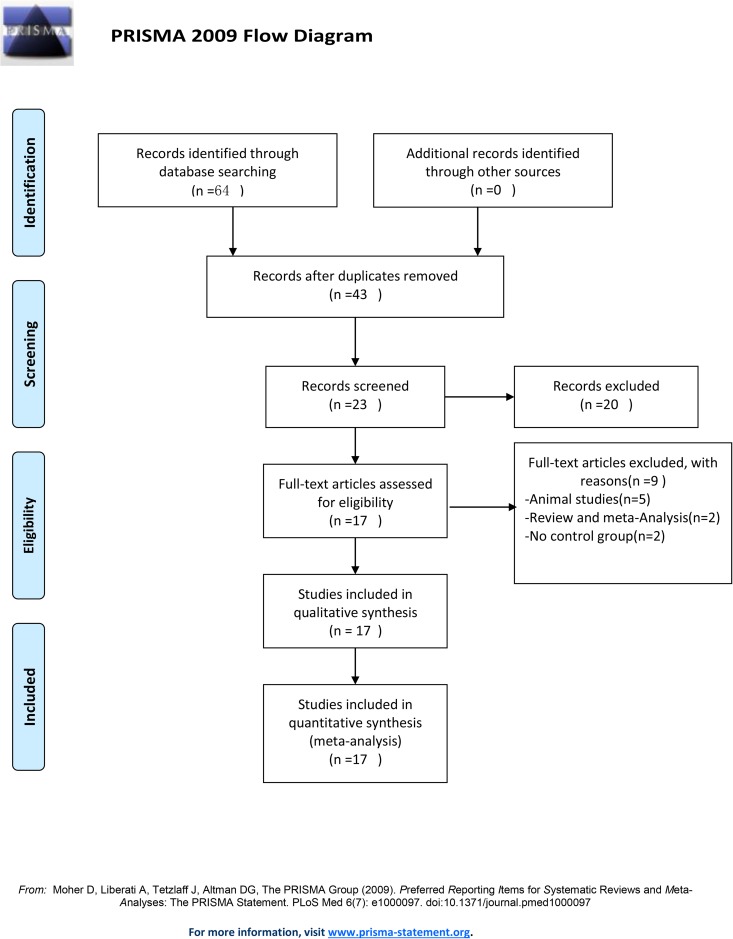
Flowchart of selection of studies for inclusion in meta-analysis.A total of 64 studies were identified, and 21 studies were excluded because of duplication. After reading the titles and abstracts, 20 studies were excluded. 23 possible full text studies were carefully reviewed (animal studies [n = 5]; review and meta-analysis [n = 2]; no control group [n = 2]). Finally, 17 trials were included for quantitative analysis.